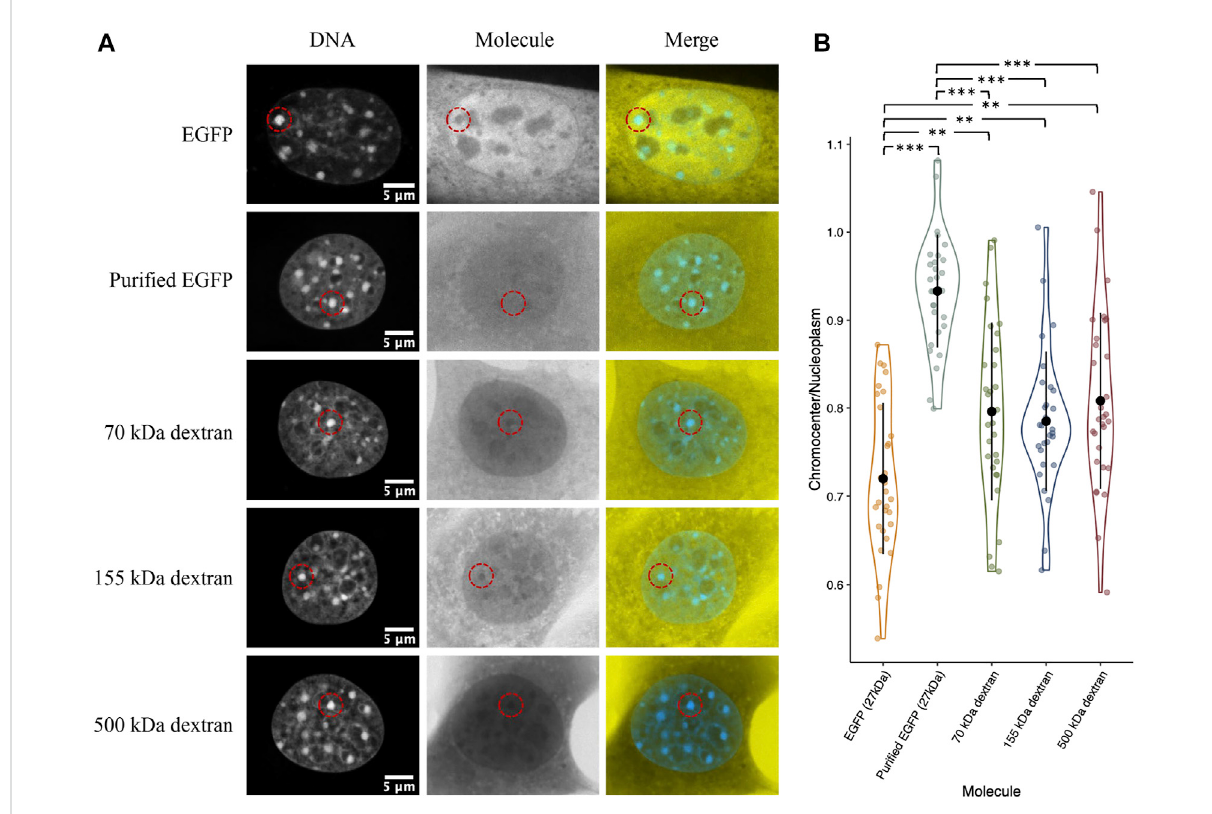
FIGURE 6 Distribution of puri fi ed recombinant GFP and fl uorescent dextrans in fi xed permeabilized cells. (A) CH3/10T1/2 cells were either fi xed with paraformaldehyde and permeabilized with Triton X followed by perfusion with puri fi ed EGFP or the indicated dextrans diluted in 1× PBS. For comparison, a cell transfected with a plasmid encoding EGFP and imaged live is also shown. Both groups were stained with Hoechst 33342 for DNA visualization. (B) Quanti fi cation of chromocenter concentration relative to the surrounding